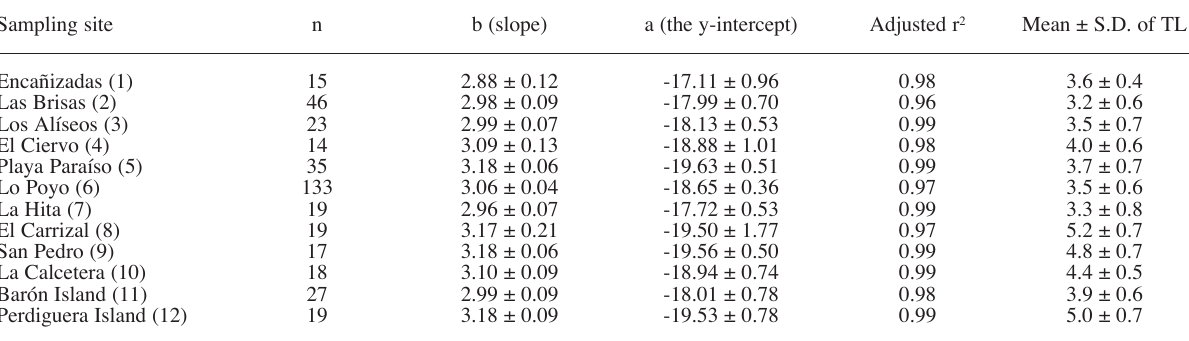
T ABLE 3. – Regression coefficients ( a, b ) ± S.D. and correlation coefficients (r) of the ln-transformed mass-length